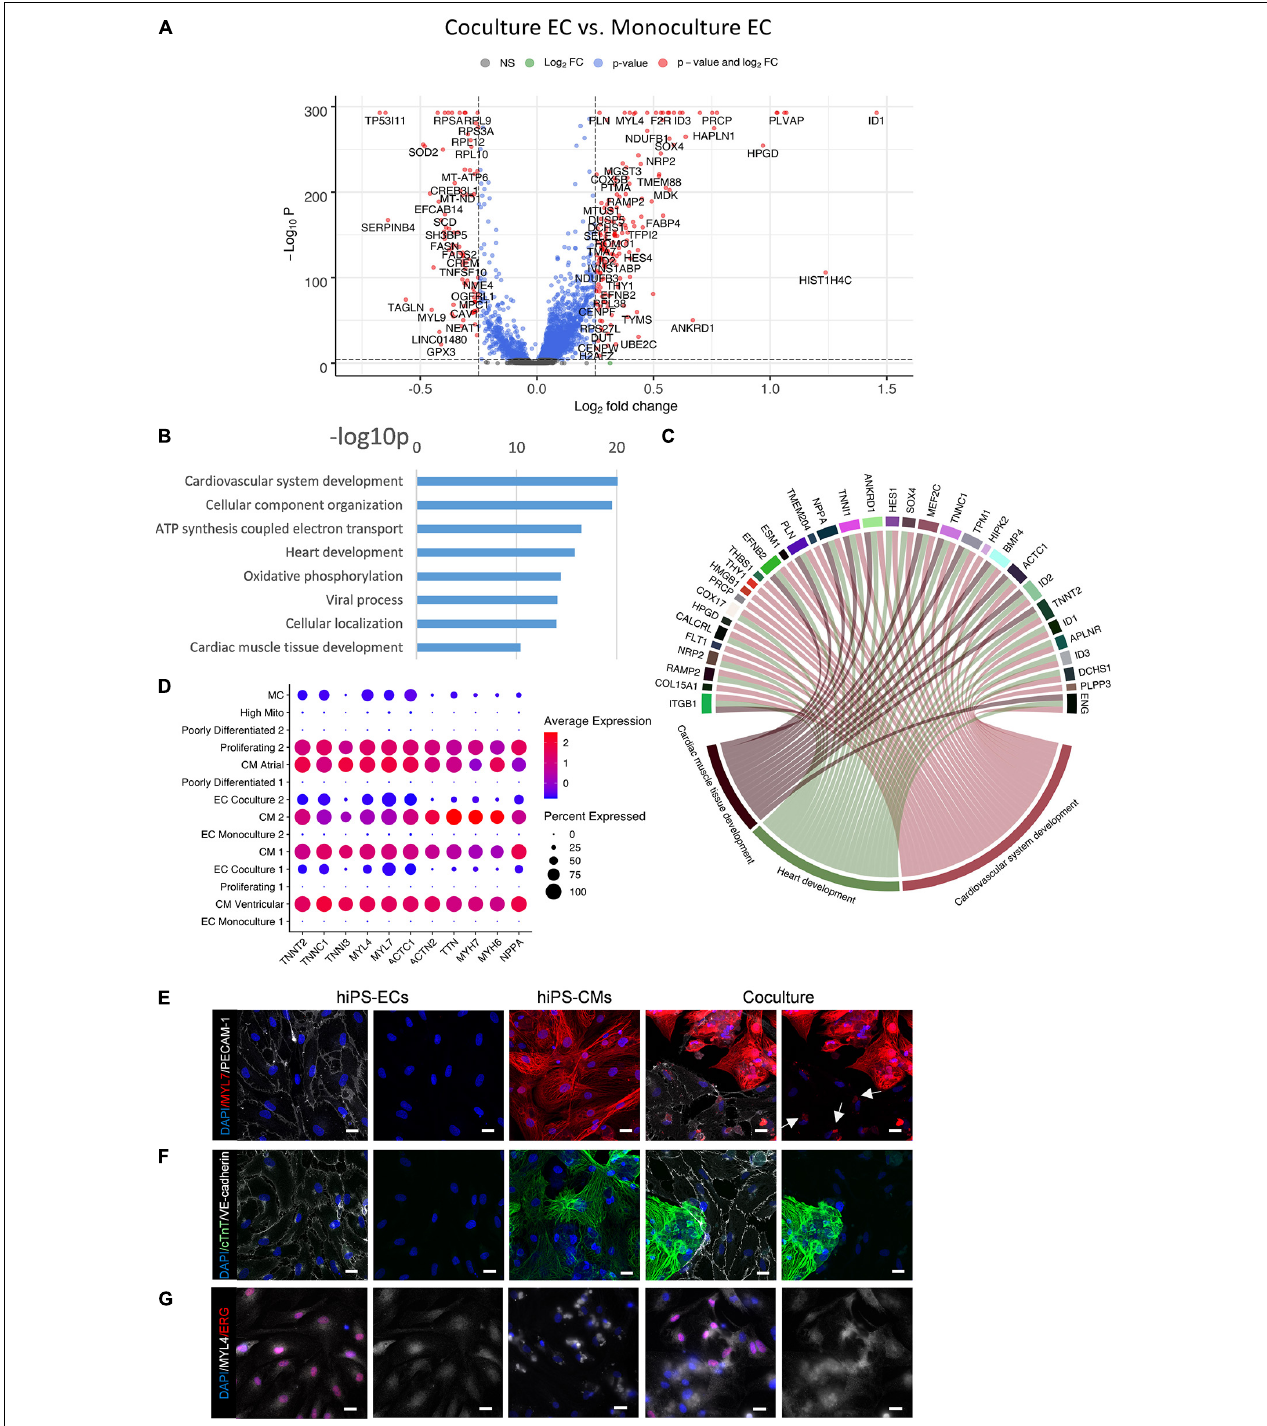
FIGURE 5 | Comparison of co-culture and monoculture hiPS-ECs. (A) Volcano plot of altered genes in co-culture hiPS-ECs compared to monoculture hiPS-ECs. (B) GO-analysis on differentially expressed genes that are upregulated (log fold change > 0.10 fdr < 0.01) in co-culture hiPS-EC’s–eight representative categories are presented. (C) Upregulated genes in relevant GO categories (genes with log fold change > 0.25). (D) Expression of cardiac contractility genes and cardiac secreted protein NPPA coding gene in all clusters. (E) Immunofluorescence staining of MYL7 in monoculture hiPS-ECs, monoculture hiPS-CMs, and hiPS-EC/hiPS-CM co-culture (scale bar 20 µ m). (F) Immunofluorescence staining of cTnT in monoculture hiPS-ECs, monoculture hiPS-CMs, and hiPS-EC/hiPS-CM co-culture (scale bar 20 µ m). (G) Immunofluorescence staining of MYL4 in monoculture hiPS-ECs, monoculture hiPS-CMs, and hiPS-EC/hiPS-CM co-culture (scale bar 20 µ m). All scRNAseq data presented in the figure consists of combined data from HEL47.2 and HEL24.3 lines. White arrows indicate MYL7 staining in hiPS-ECs.